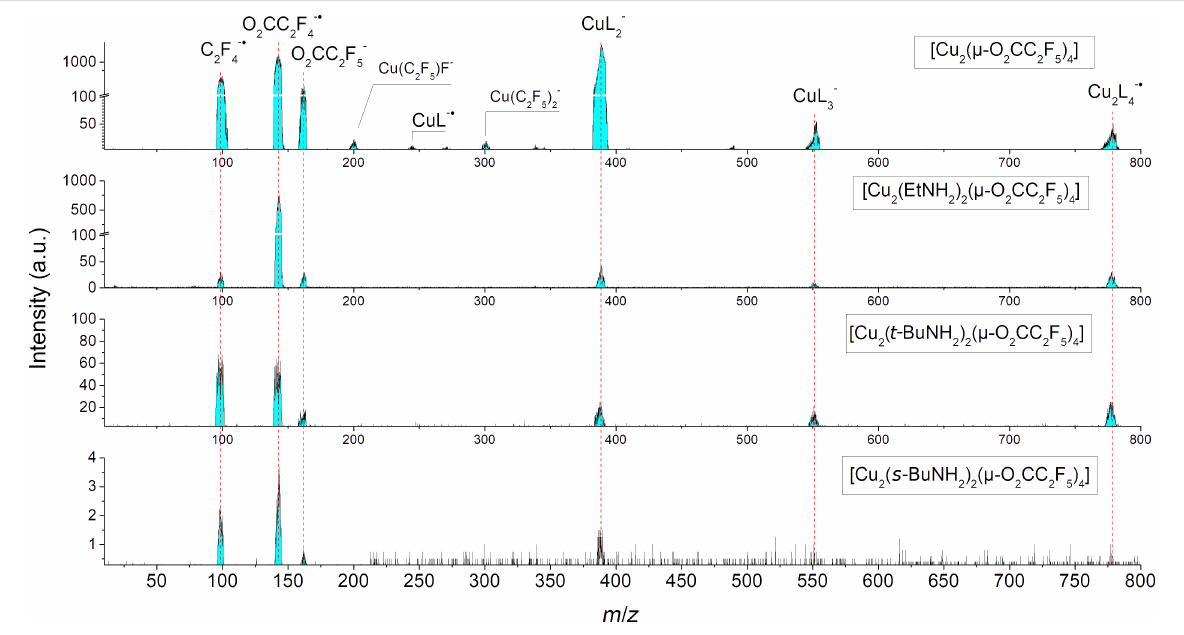
Figure 7: Negative ions mass spectra of copper carboxylate molecules. The spectra were obtained at the energy where maximal ion count of SF 6 − ion production from SF 6 is observed, which is close to 0 eV.